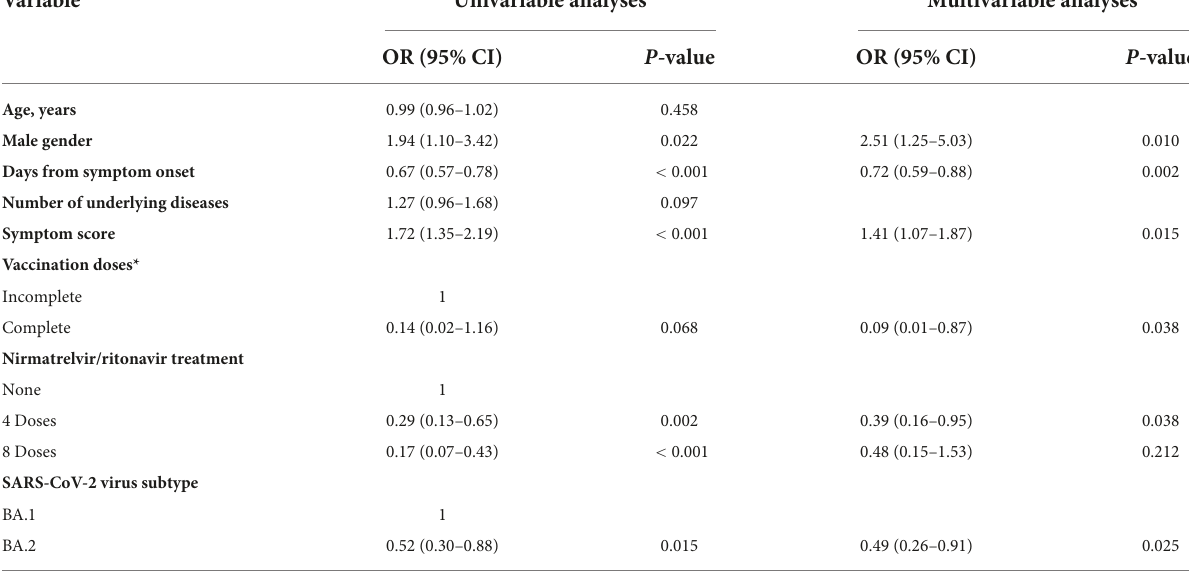
TABLE 2 Univariable and multivariable analyses of all collected specimens to identify factors influencing culture positivity in mildly ill COVID-19 patients. Variable Univariable analyses Multivariable